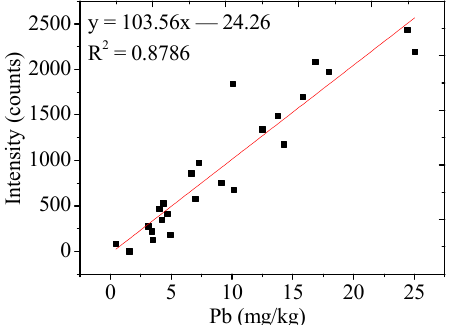
Figure 8. Calibration curve of low content Pb.